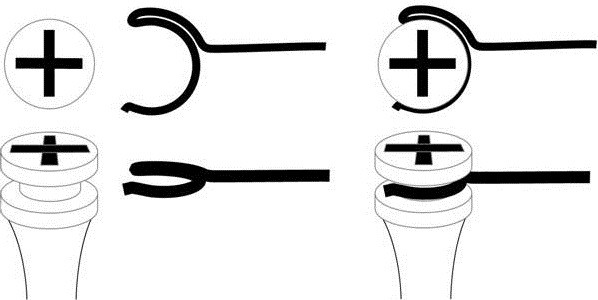
Connecting clip.